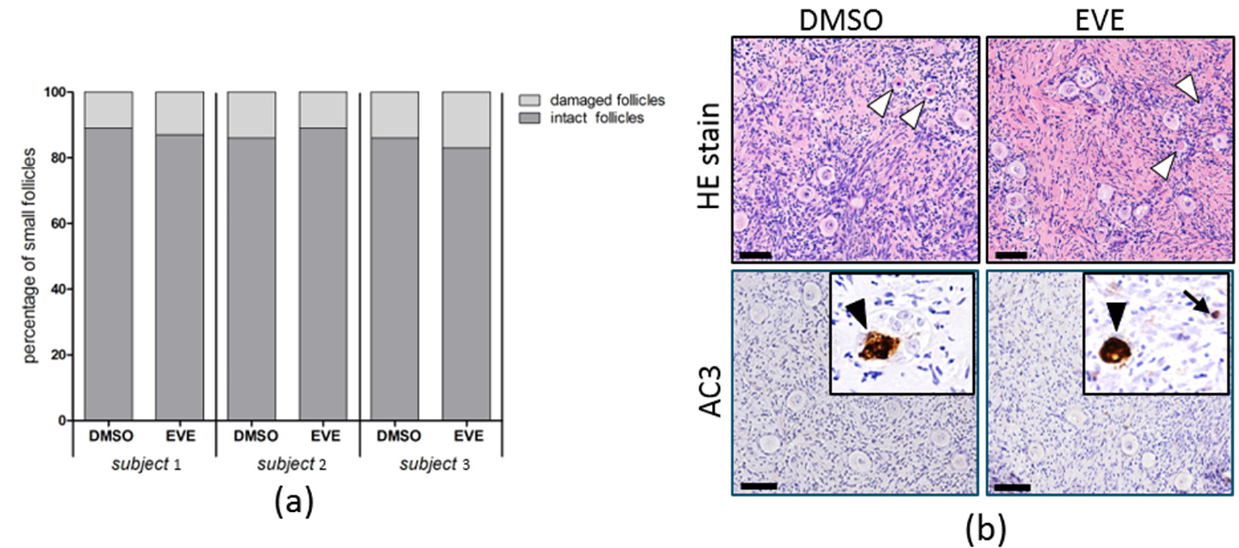
Figure 6. Follicular morphology after 24 h of purging with Everolimus. ( a ) To determine the possible adverse effects of EVE on follicles, ovarian cortex tissue of three individuals was exposed for 24 h to 50 µM EVE or solvent only. After washing the tissue was cultured for an additional 24 h to allow any morphological defects to become apparent. Per condition at least 100 follicles were analyzed. The percentage of morphologically intact small follicles of tissue after EVE exposure was very similar to the control tissue. ( b ) Representative images of HE staining of tissue treated with EVE or solvent-only showing many small follicles with normal morphology and some follicles with damaged pyknotic/eosinophilic oocytes (white arrowheads). Immunostaining of active Caspase-3 (AC3) was used to determine the presence of apoptotic ovarian cells after purging. Apoptotic cells were virtually absent (insets) with only very few positive oocytes (black arrowheads) or stromal cells (black arrow). Bars indicate 100 µm. DMSO, dimethyl sulfoxide.